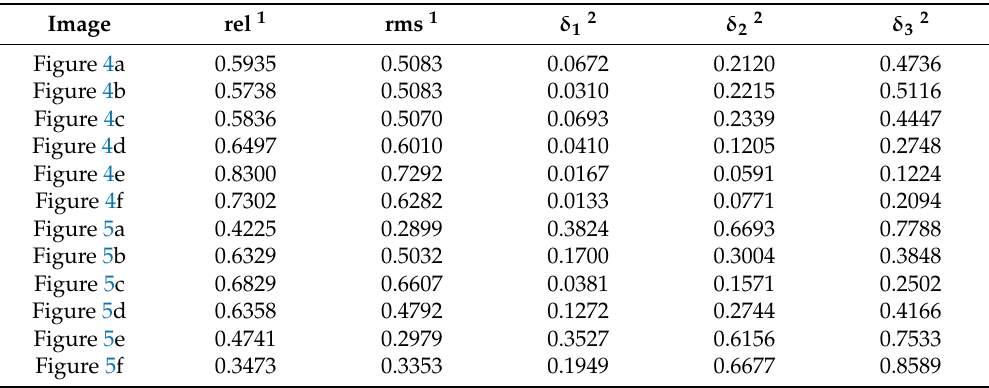
Table 2. The quantitative analysis of the